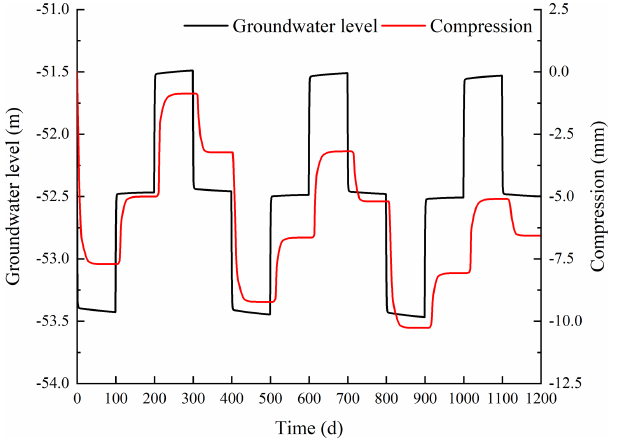
Figure 4. Compressed volume and water level with stress period in the third confined aquifer group under the second pumping and recharge